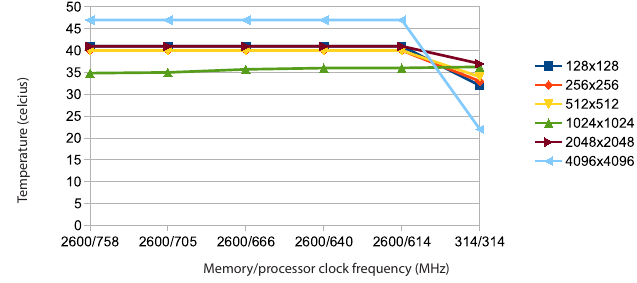
Figure 21. The GPU